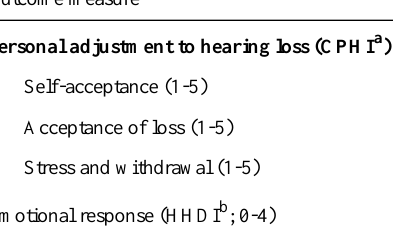
Table 1. Secondary outcomes measures (ranges) and time points. t3t2t1t0Outcome